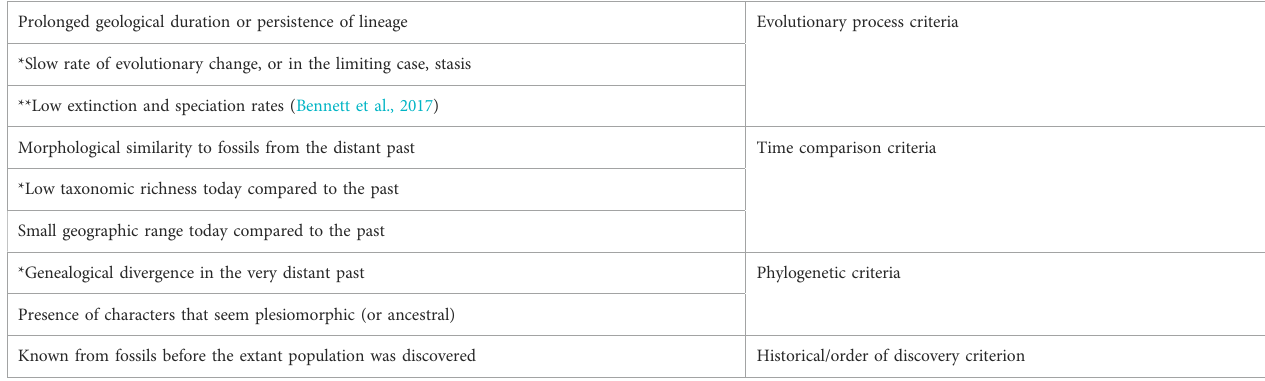
TABLE 2 Criteria for Counting as a Living Fossil, following Lidgard and Love (2018) (p. 761). Prolonged geological duration or persistence of lineage Evolutionary process